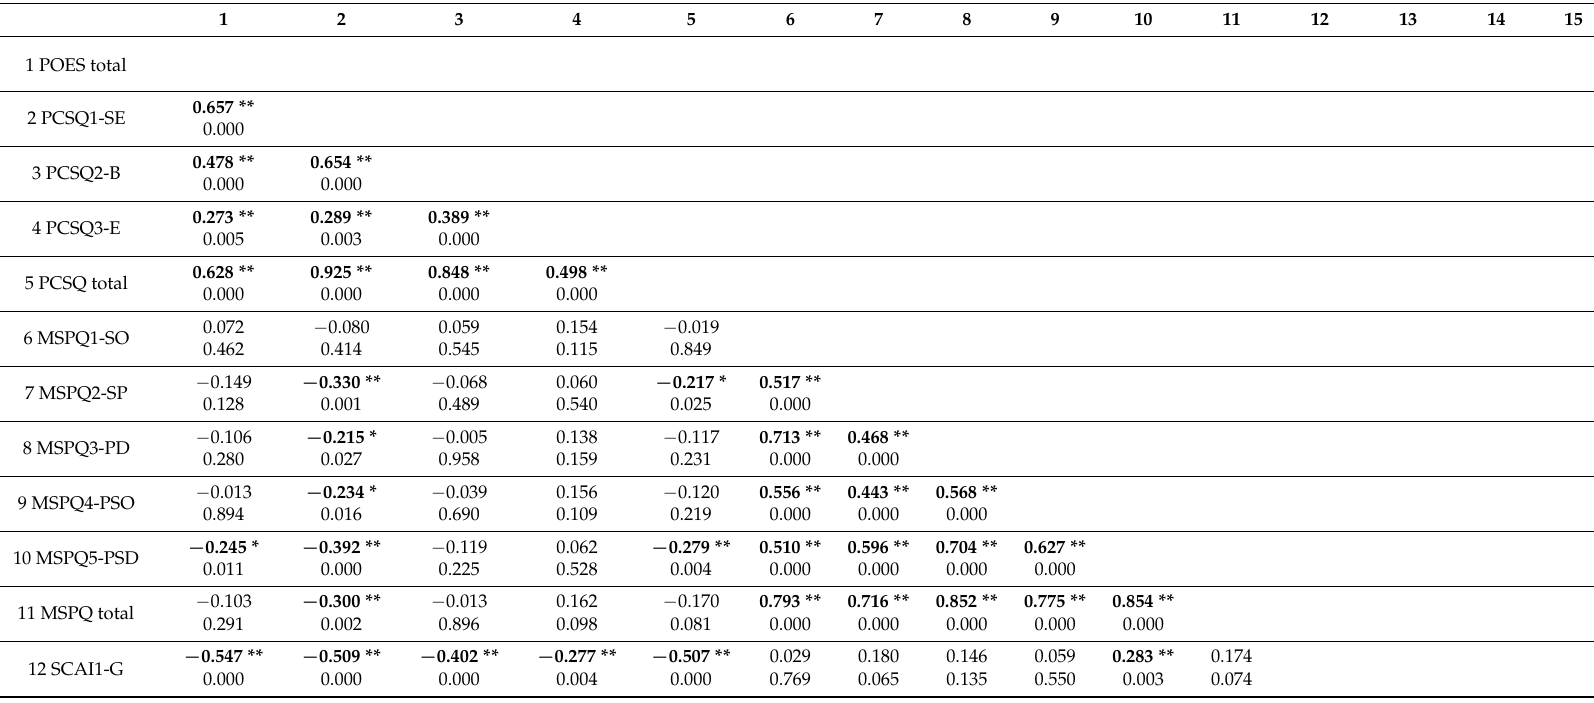
Table 1. Spearman bivariate correlation coefficients for study variables (and dimensions) and significance